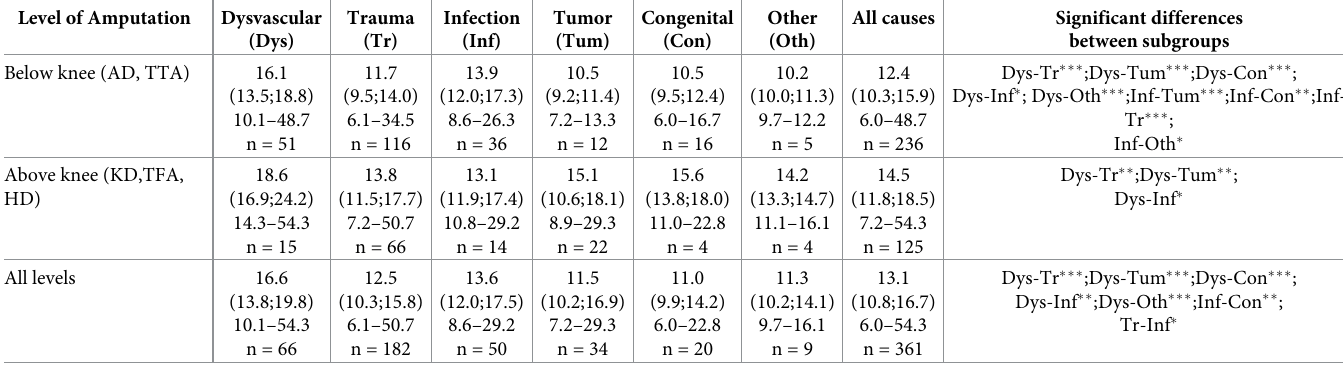
Table 4. The m5xSTS test times (seconds) by level and cause of amputation (n = 361). Median and quartiles are provided for each subgroup in the following format: Median (75th quartile;25th quartile), minimum-maximum, and subgroup sample size. Level of